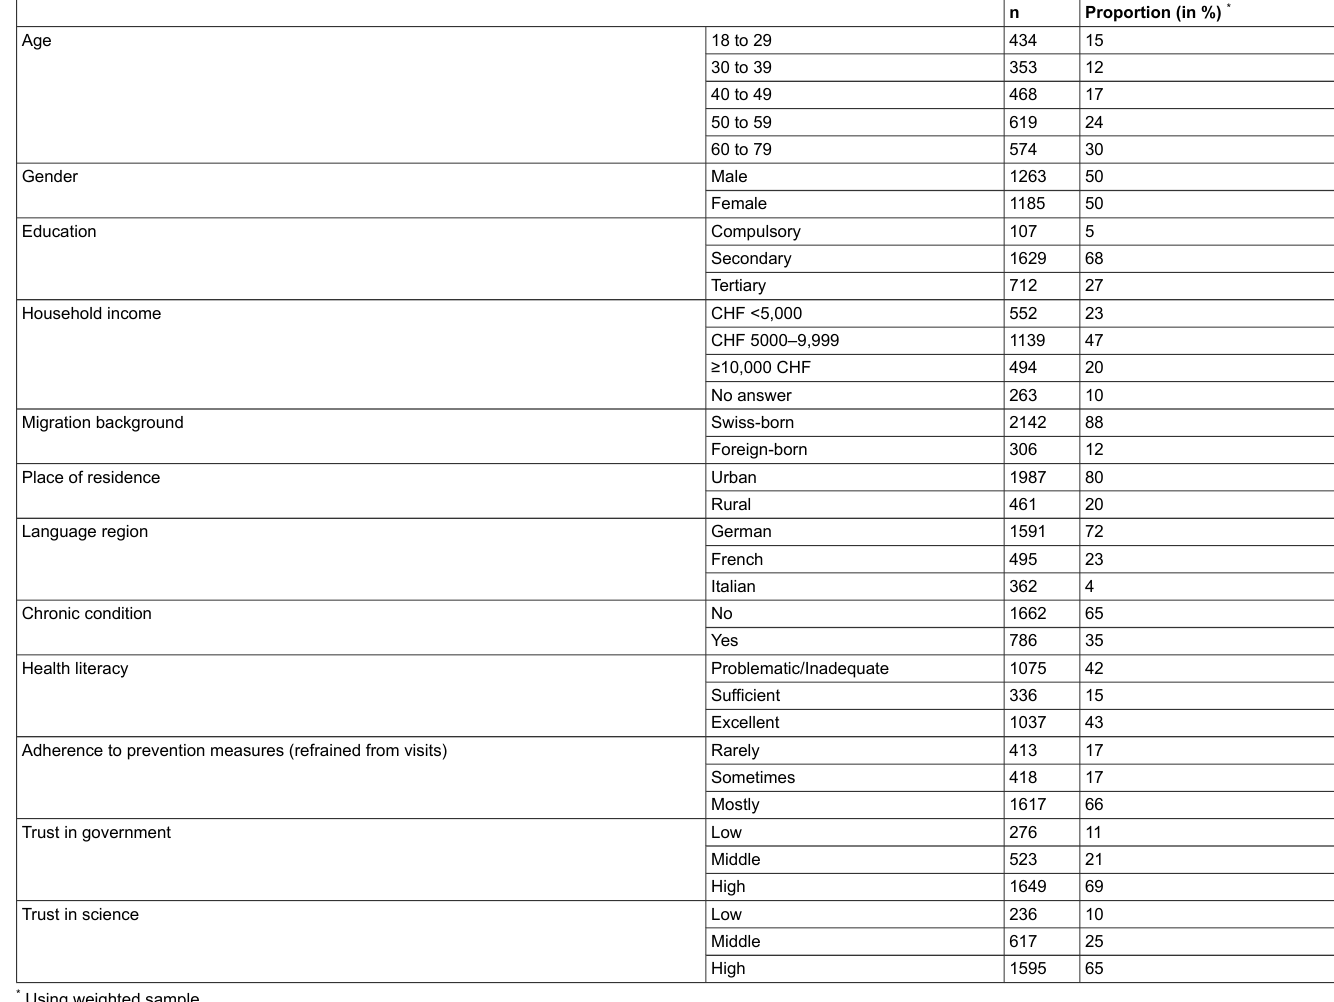
Table 2: Characteristics of study population (n =